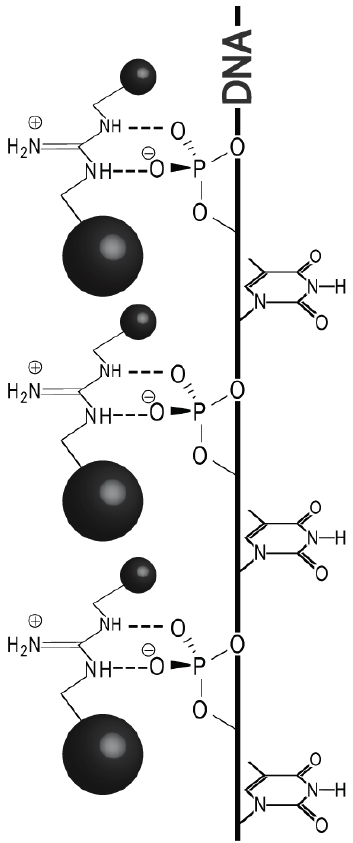
Scheme 1. Schematic representation of the single-stranded DNA-templated self-assembly of bis -functionalized guanidinium ligands that recognize the phosphodiester backbone of DNA through salt bridges. The presence of side-groups (represented as spheres) may affect the stability of these self-assemblies through self-association or secondary interactions with the ssDNA